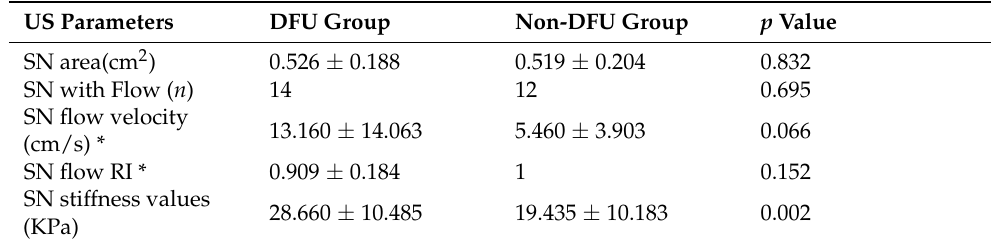
Table 2. Ultrasound findings of the sciatic nerve in 16 patients with unilateral diabetic foot ulcers.